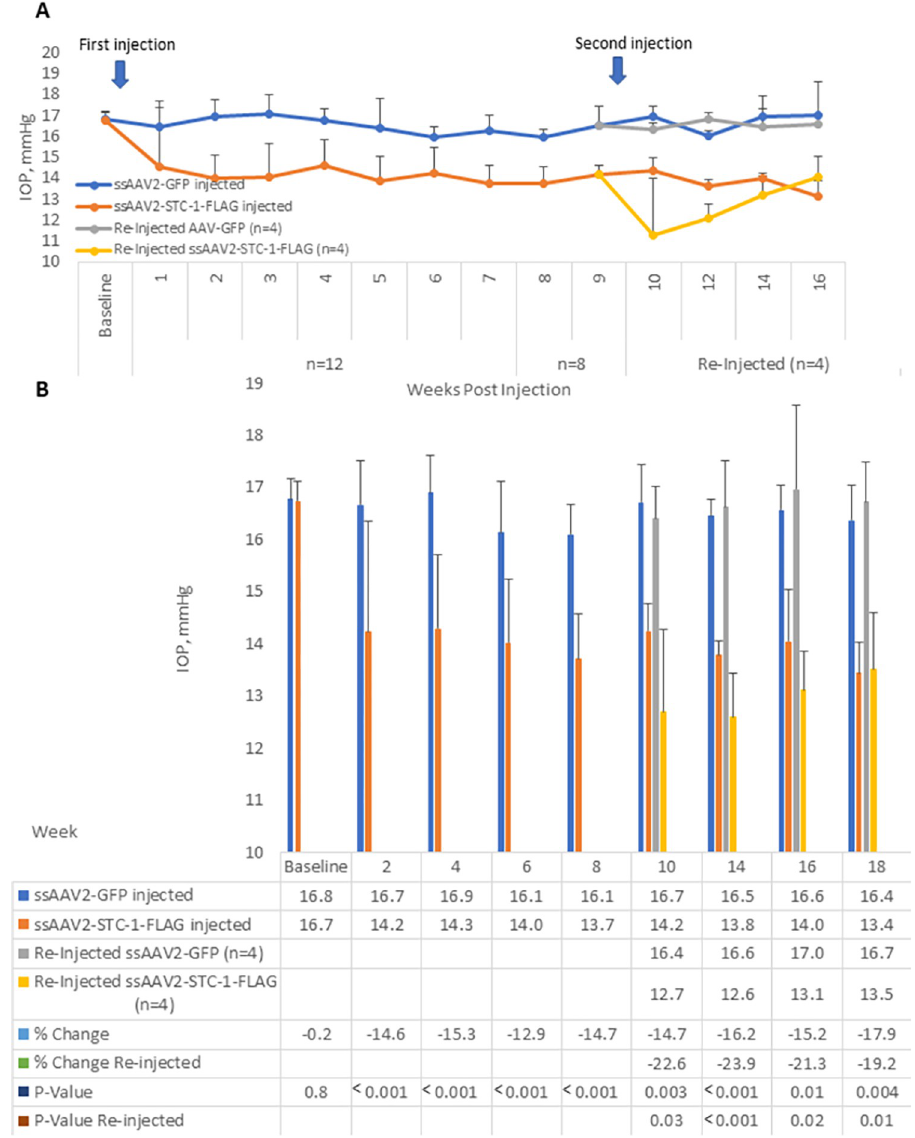
Fig 4. ssAAV2-STC-1-FLAG reduces IOP compared to ssAAV2-GFP. A) After baseline IOP measurements, ssAAV2-STC-1-FLAG (3x10 9 VGs) was injected in one eye and ssAAV2-GFP (3x10 9 VGs) was injected into the fellow eye (n = 22) of 3-month-old C57BL/6J mice. IOP was lowered by week 1. At the end of week 8, remaining mice in the study (n = 8) were randomized to continue without further treatment (n = 4) or receive a second injection (n = 4). By the end of week 16, there was no detectable difference in IOP lowering between once-injected and twice-injected ssAAV2-STC-1-FLAG treated mice. B) Similar data presented in a bar graph format with statistical analysis performed bi-monthly